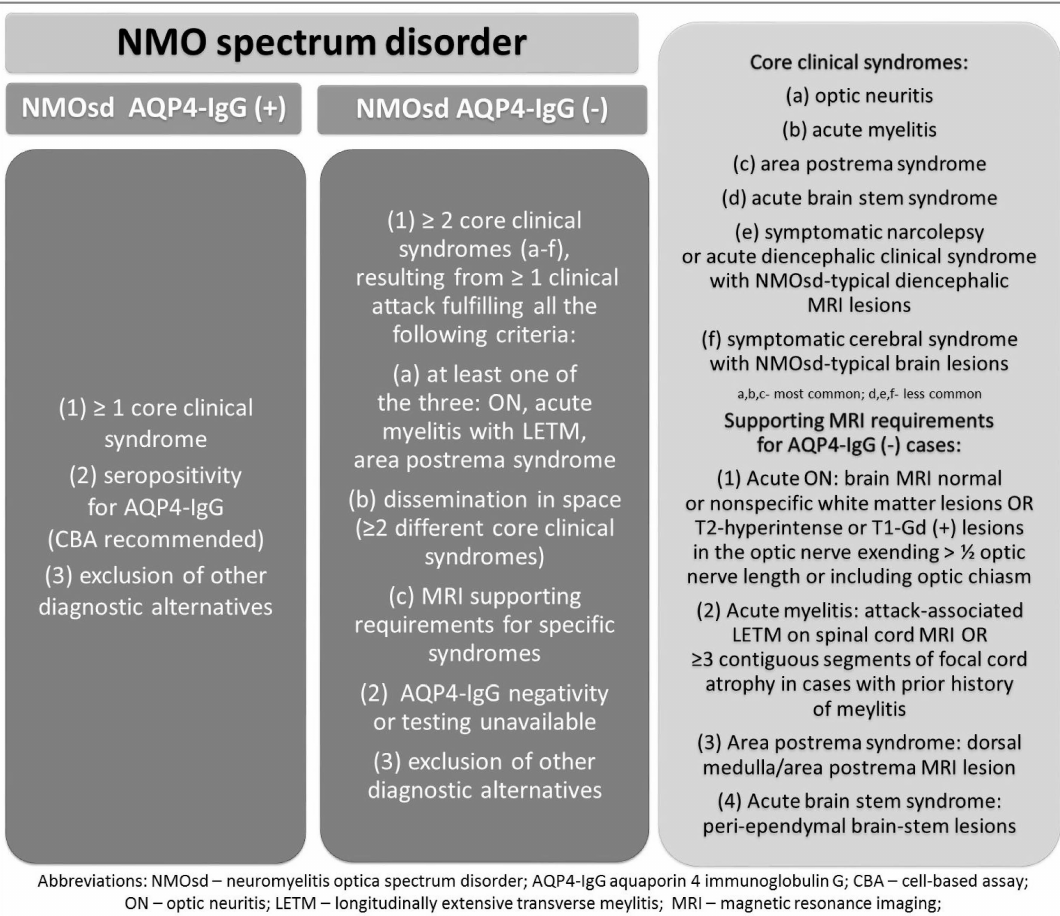
Figure 1. Diagnostic criteria for neuromyelitis spectrum according to International Panel for Neuromyelitis Optica (NMO) Diagnosis (2015) [8]. NMOsd: NMO spectrum disorders; AQP4-IgG: aquaporin-4 immunoglobulin G; MRI: magnetic resonance